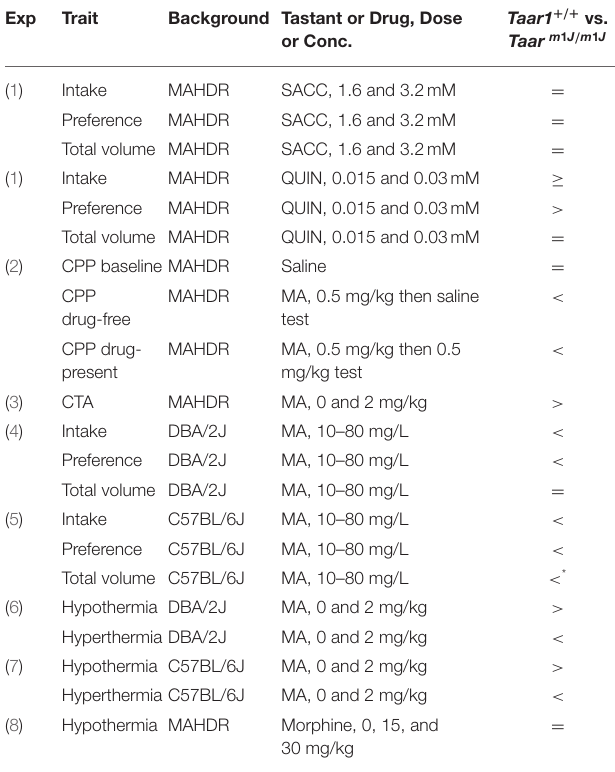
TABLE 2 | Summary of results for Taar1 genotype effects for all experiments. Taar1 + / + Exp Trait Background Tastant or Drug, Dose or Conc.